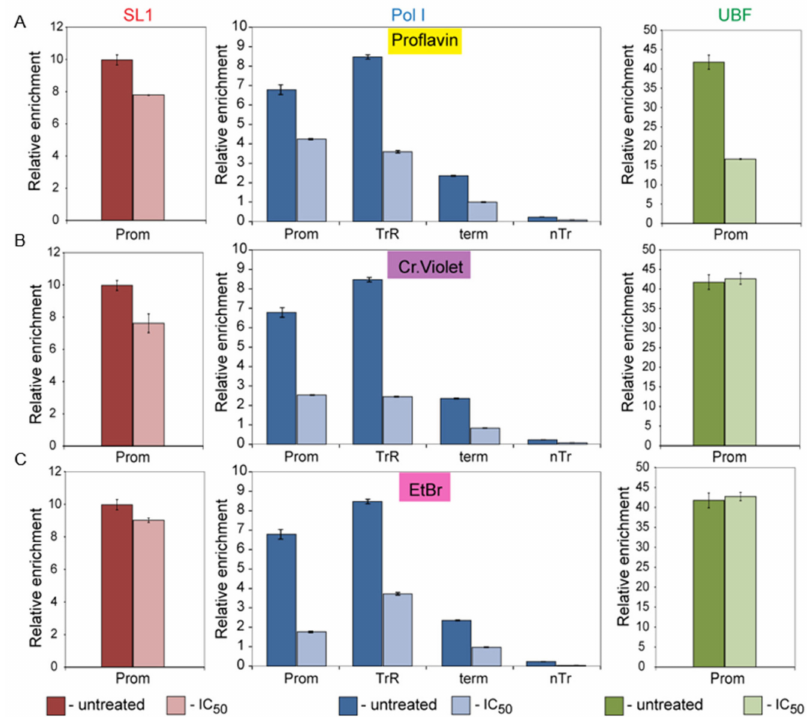
Figure 6. ChIP analysis of the rDNA repeat reveals that intercalating compounds alters Pol-I occupancy at rDNA. HCT116 p53 − / − cells grown to 70% confluence and were either with proflavine (Pro) ( A ), or Crystal Violet (CV) ( B ) or Ethidium Bromide (EtB) ( C ) for 30 min prior to chromatin crosslinking. Concentration of all drugs were equal to the IC 50 in vivo (Table 2). ChIP assays were performed using antibodies specific either to TAF I 110 subunit of human SL1 complex (left panel), or to A194 subunit of human Pol-I complex (middle panel) or to human UBF (right panel). Purified, immunoprecipitated DNA was analyzed by qPCR using specific probes and primers derived from different regions of rDNA repeats as described earlier [18]. Internal standards were used for absolute quantification of immunoprecipitated DNA and chromatin input. The value of each bar represents the difference between the signals from the specific antibody and from the negative control (an appropriate IgG) expressed as % from total chromatin input. Signal representing the transcribed region (TrR) is the average of the combined signal from 5’ETS, 18S, 5.8S and 28S regions of rRNA. Signal representing the non-transcribed region (nTrR) is the average of the combined signal from IGS1 and IGS2 regions. The standard deviations from three independent experiments are shown; n =